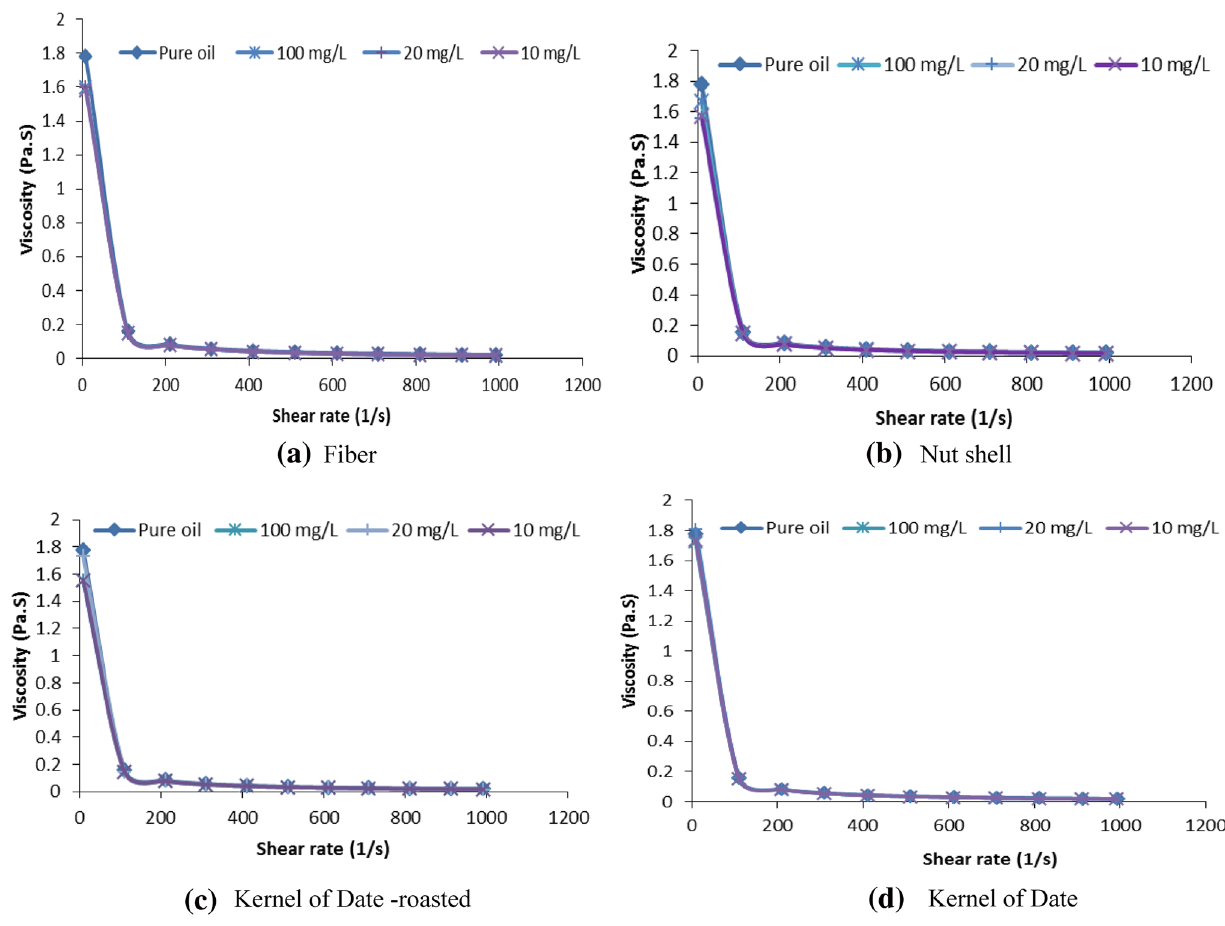
Fig. 11 Viscosity of heavy crude oil using bio materials (150 µm)